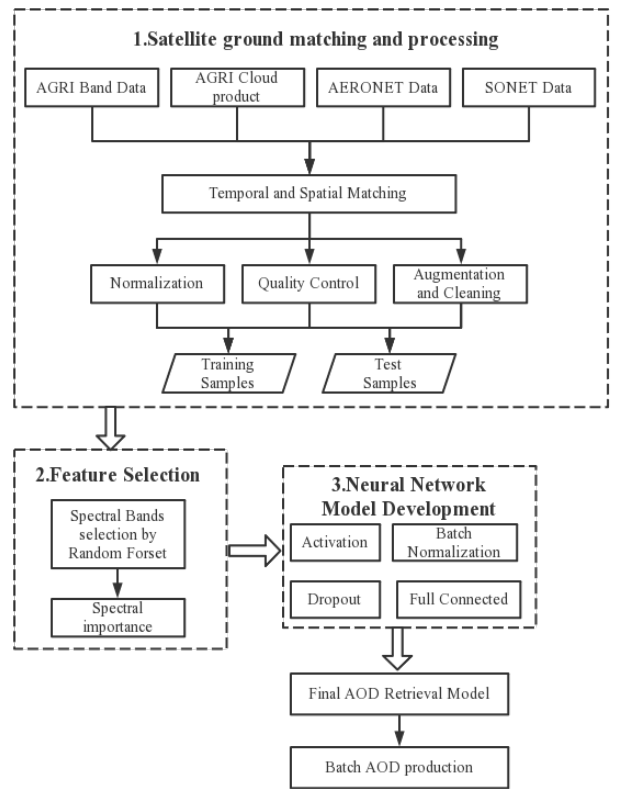
Figure 2. Flow chart of NNAeroG training and validation, modulated for FY-4A/AGRI AOD esti- mation.